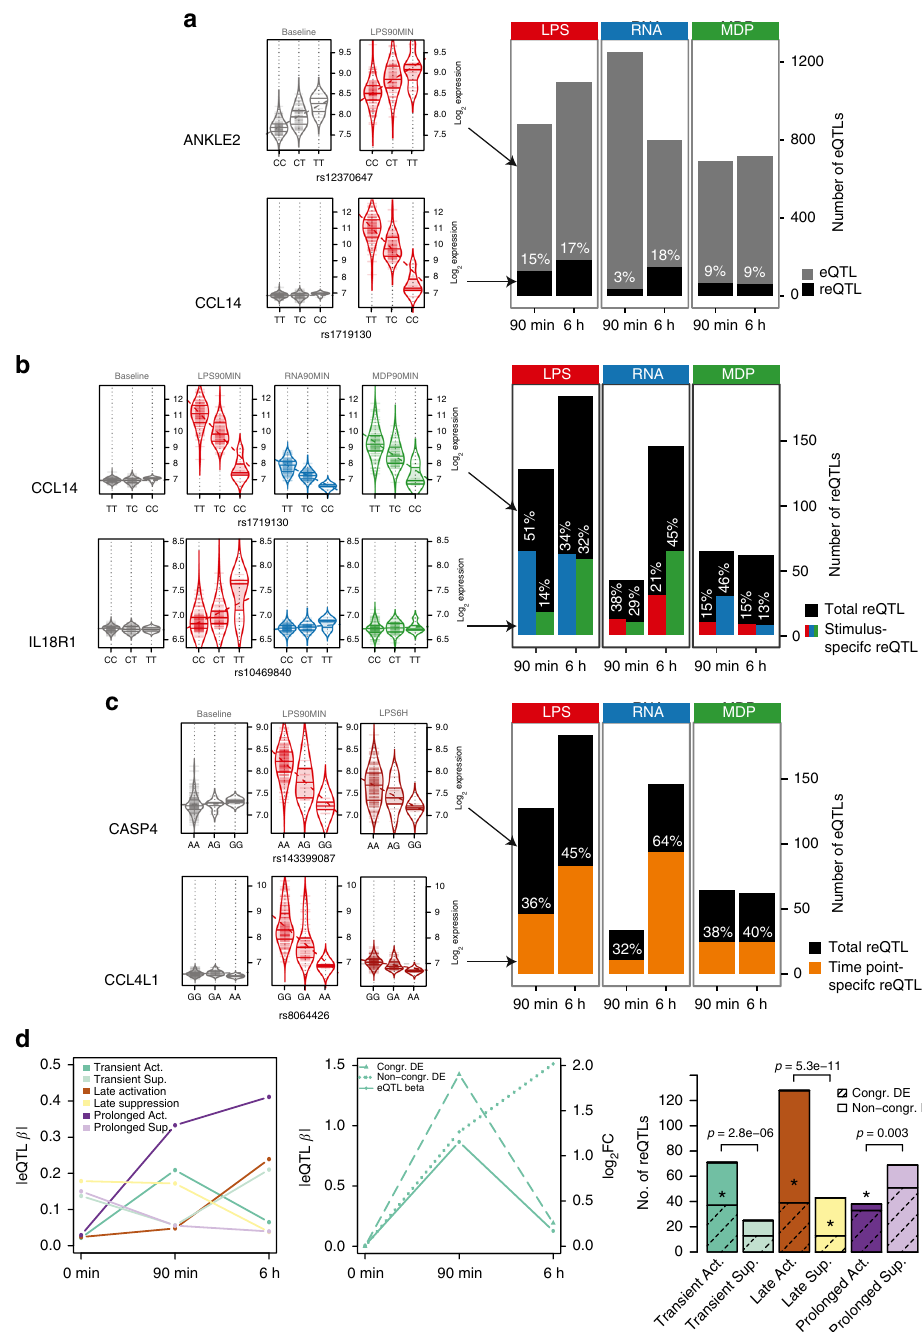
Fig. 2 Immune response eQTL study in human monocytes. a Total numbers of cis eQTLs and proportions of reQTLs of LPS-treated (LPS), 5 ′ -ppp-dsRNA (RNA) and MDP-treated (MDP) monocytes at 90 min and 6 h after stimulation. Results of the analysis of 134 individuals are shown unless indicated otherwise. eQTLs include all genes with a signi fi cant genetic association in each stimulated condition, and reQTLs are a subset that show a signi fi cant difference of the regression slope between untreated and stimulated monocytes, with violin plots shown as examples. The untreated condition has 1653 eQTLs that are not shown in the bar plot . b Numbers of reQTLs and proportions of treatment-speci fi c reQTLs where the regression slope of the tested treatment is different from the slope of the other two treatments within the same time point, with violin plots shown as examples and the color of bar indicating the treatment that was tested. c Numbers of reQTLs and proportions of time point-speci fi c reQTLs where the regression slope of the tested time point is different from the slope of the other time point within the same treatment, with violin plots shown as examples. d reQTLs were divided into six subsets according to their temporal activity (see Methods section). Average of absolute eQTL effect sizes per category is shown on the left panel . The middle panel illustrates a reQTL example with congruent differential expression (DE) ( dashed line ) or non-congruent DE ( dotted line ) of the eGene. reQTL distribution to different categories is shown in the right panel , where the shaded portion illustrates the proportion of reQTLs with congruent DE of the eGene and asterisks represent the signi fi cance of enrichment of reQTLs with congruent DE of the eGene (Fisher ’ s exact test * p < 0.05). The p -values above the bars indicate the signi fi cance between of active and suppressive types (binomial test)